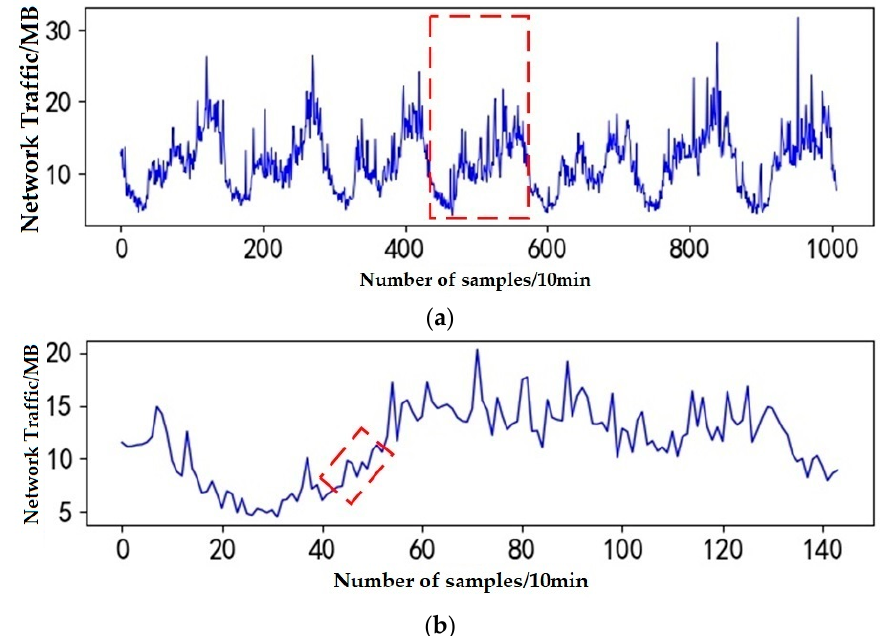
Figure 2. The temporal dependency diagram for network traffic. ( a ) The weekly trend. ( b ) The daily trend.